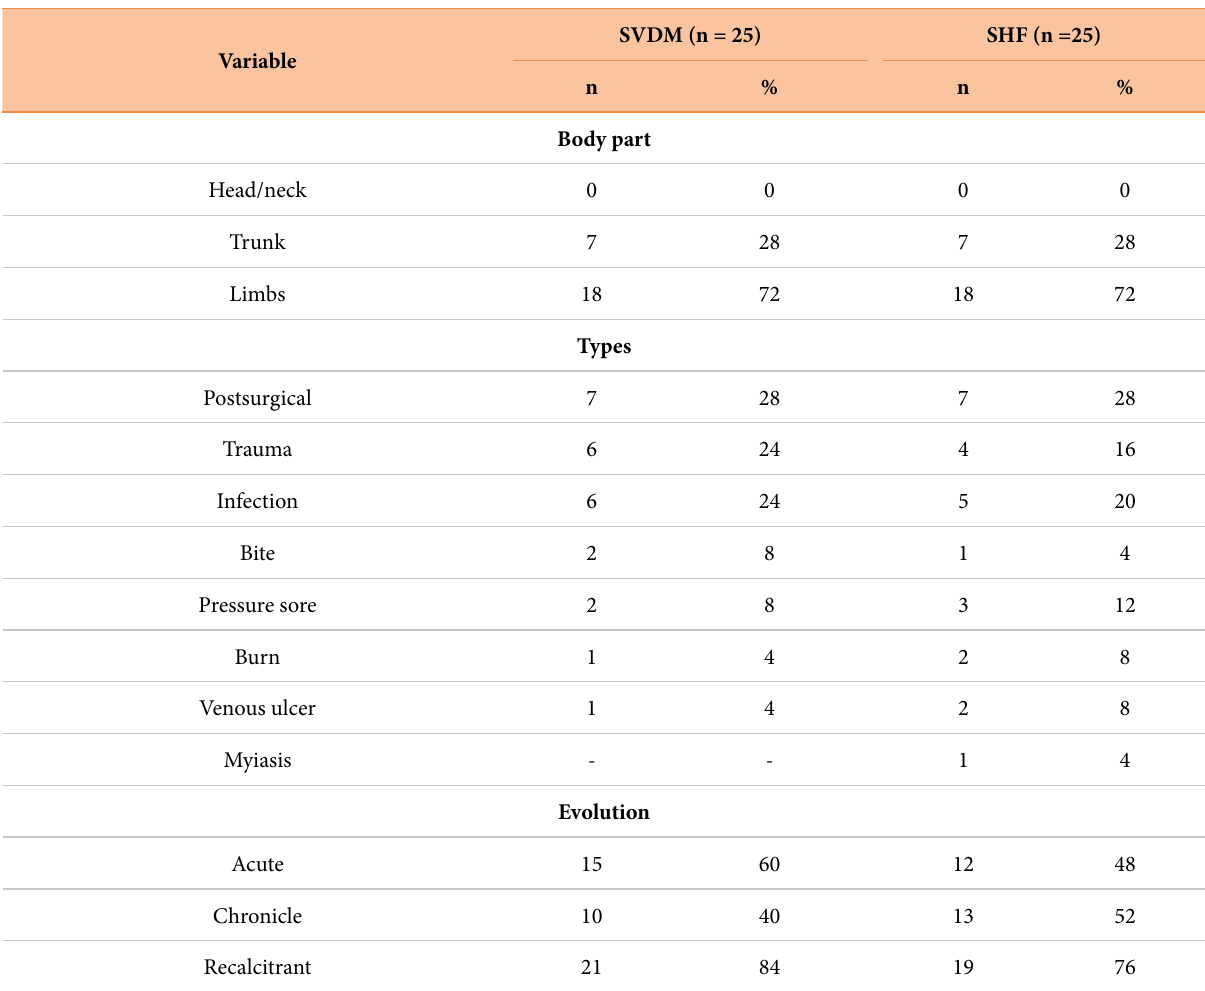
Table 3 - Location, type, and evolution of wounds according to